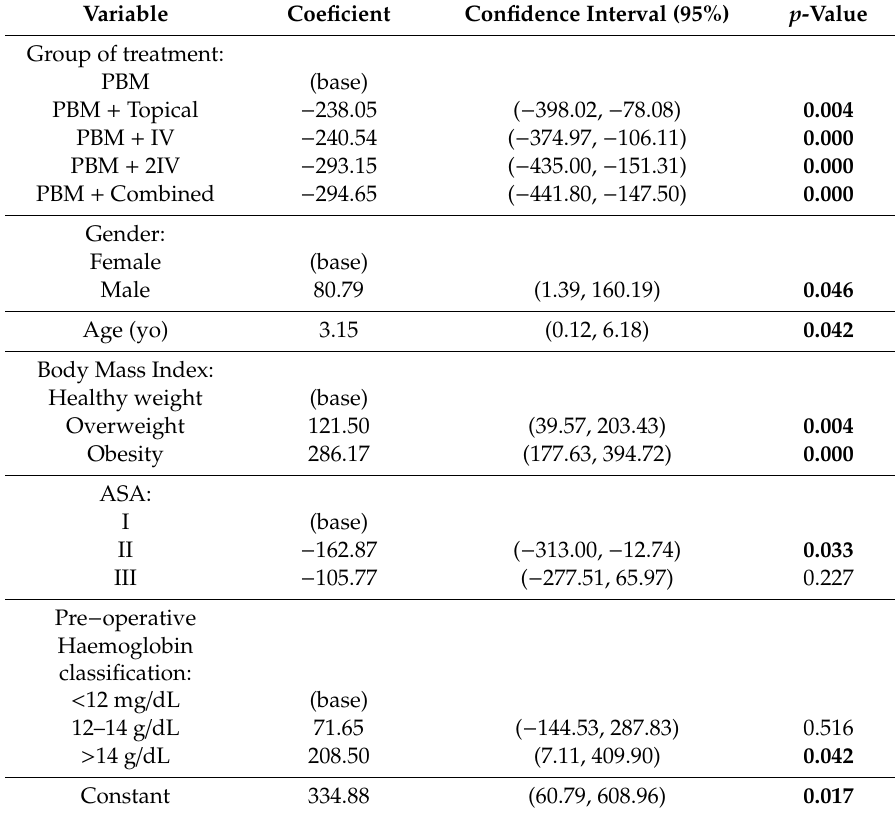
Table 3. Generalised linear model analysis of the association of regimen of treatments with total blood volume loss at 48 h postoperative, adjusted for